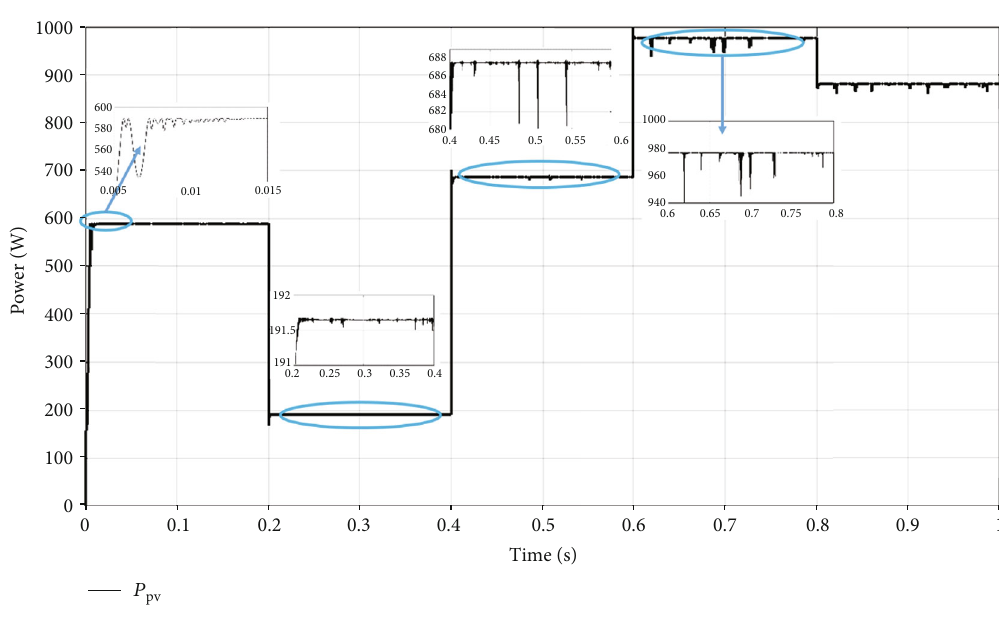
Figure 15: PV array